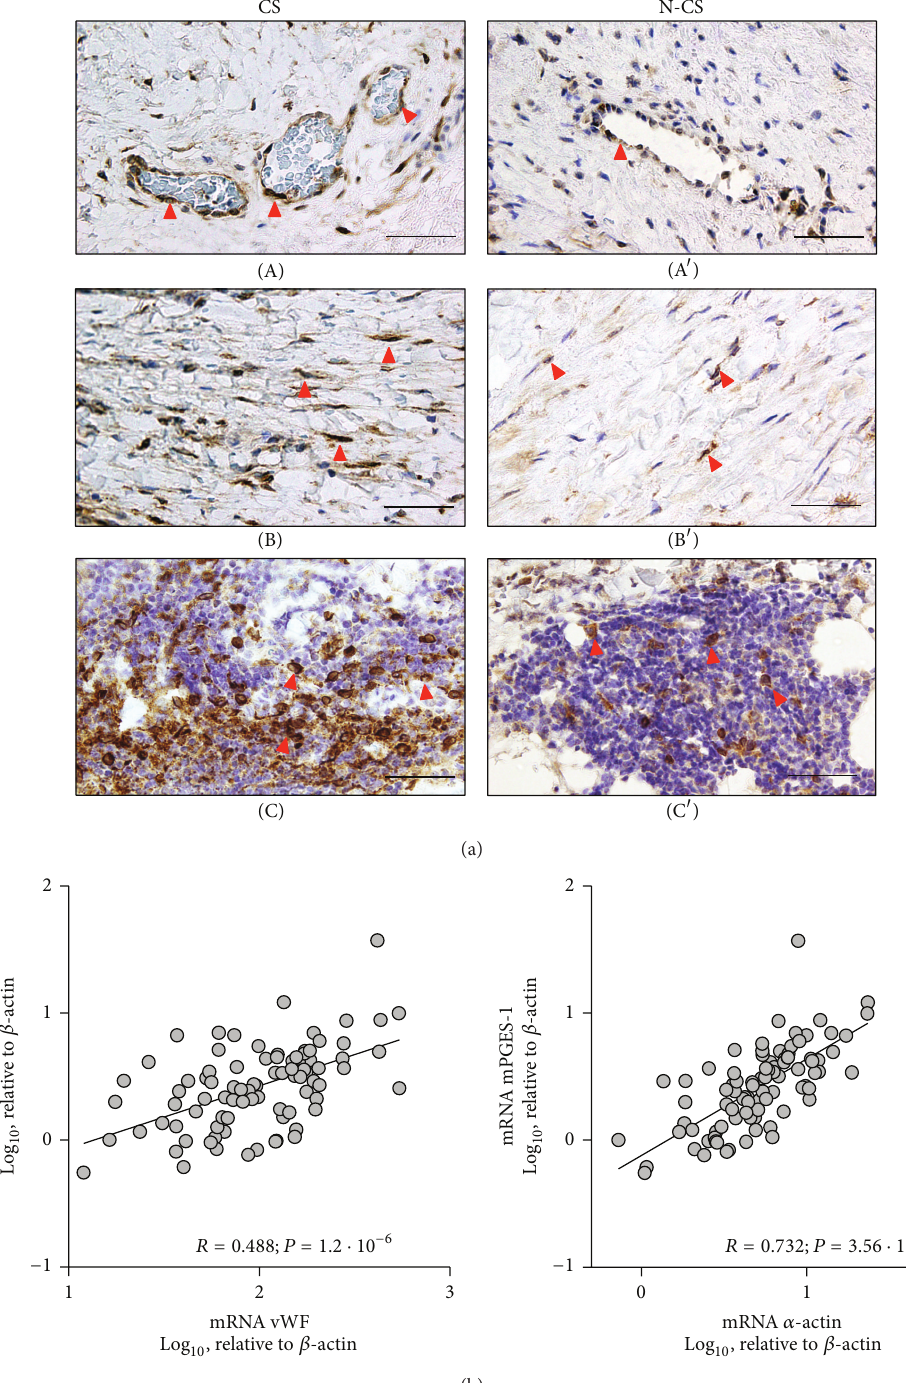
Figure 2: (a) Representative immunohistochemical images of mPGES-1 in aorta samples from current smokers (CS, left) and noncurrent smokers(N-CS,right)patients,showingmPGES-1immunostainingofMVEC(A,A 󸀠 ),VSMCofthemedialayer(B,B 󸀠 ),andmPGES-1positive leukocytes (C, C 󸀠 ). Red arrow-ends indicate some immunostained cells. Size bars: 50 𝜇 m. (b) Correlation between mPGES-1 transcript levels and those of vascular cell markers; Pearson product moment correlation applied to log 10-transformed data ( 𝑛 = 89